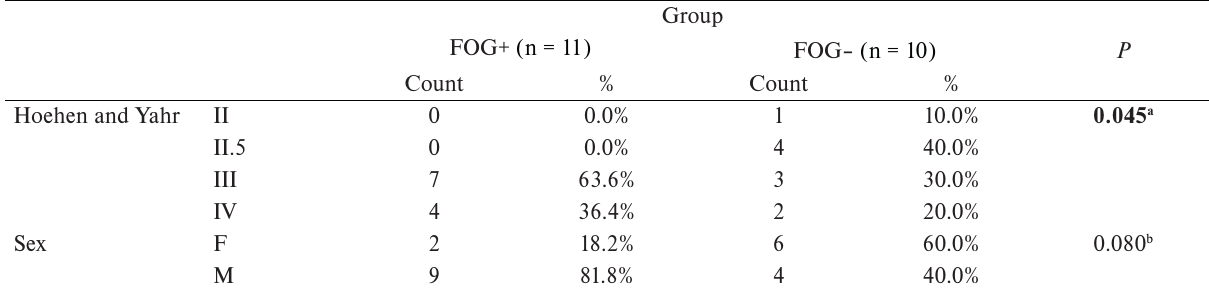
Table 2. Clinical group characteristics – ordinal and categorical variables.